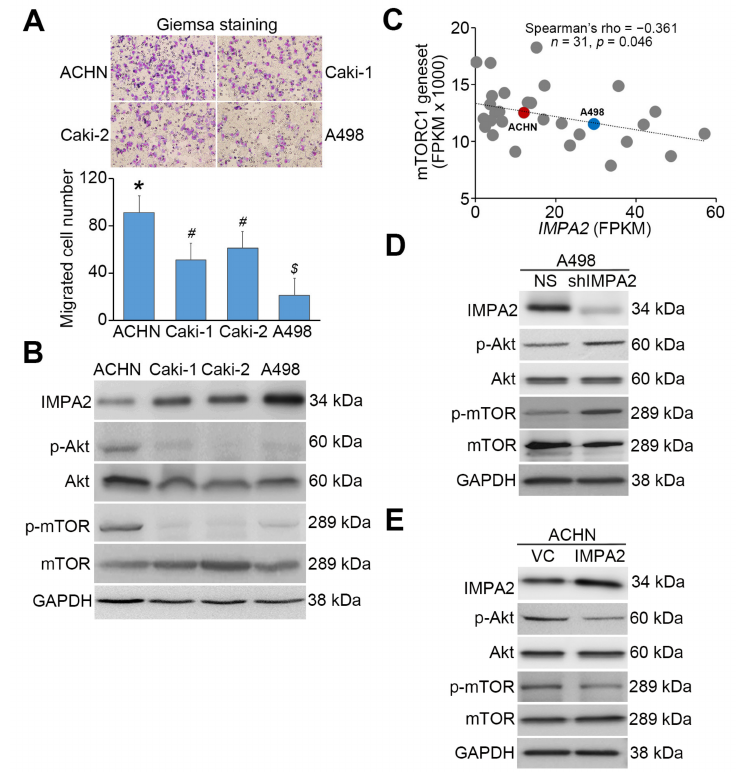
Figure 2. IMPA2 expression negatively regulates Akt / mTORC1 phosphorylation and cellular migration abilities in ccRCC cell lines. ( A ) Giemsa staining (Top) and data from three independent experiments (bottom) for the migrated cells (purple staining) in the 3 h transwell assay for the ccRCC cells. Error bars represent the mean ± SEM of data obtained from three independent experiments and the statistical di ff erences were analyzed by Kruskal Wallis test. Di ff erent symbols in each column indicate the statistical significance at p < 0.05. ( B ) Western blot analyses for IMPA2, p-Akt (Tyr308), Akt, p-mTOR (Ser2448), mTOR and GAPDH proteins in whole cell lysates derived from the tested ccRCC cell lines ACHN, Caki-1, Caki-2 and A498. ( C ) Correlation of transcriptional profiling between IMPA2 and mTORC1 gene set in a panel of RCC cell lines from Cancer Cell Line Encyclopedia database. Spearman’s correlation test was used to estimate the statistical significance. ( D and E ) Western blot analyses for IMPA2, p-Akt, Akt, p-mTOR, mTOR and GAPDH proteins in whole cell lysates derived from A498 cells without (non-silencing, NS) or with IMPA2 knockdown ( D ), and ACHN cells without (vector control, VC) or with IMPA2 overexpression ( E ). In B , D , E , GAPDH was used as an internal control of protein